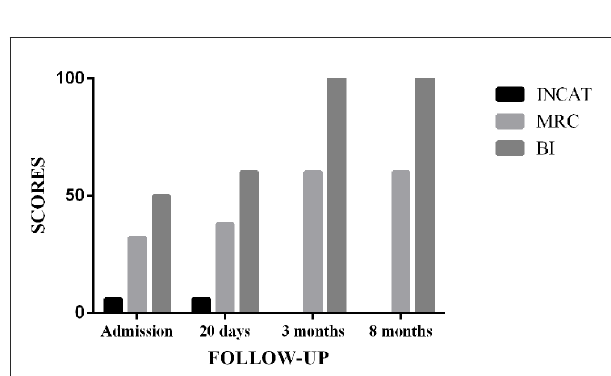
were observed. The patient was diagnosed with CIDP using the EFNS/PNS consensus guideline (4).